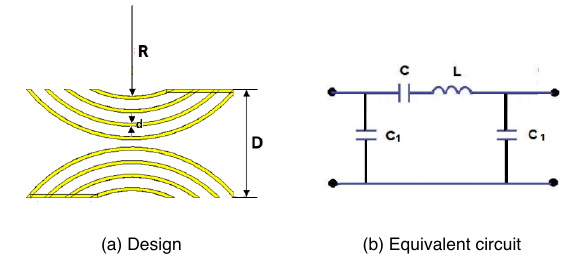
FIGURE 8. The proposed decoupling structure based on gradient arcs